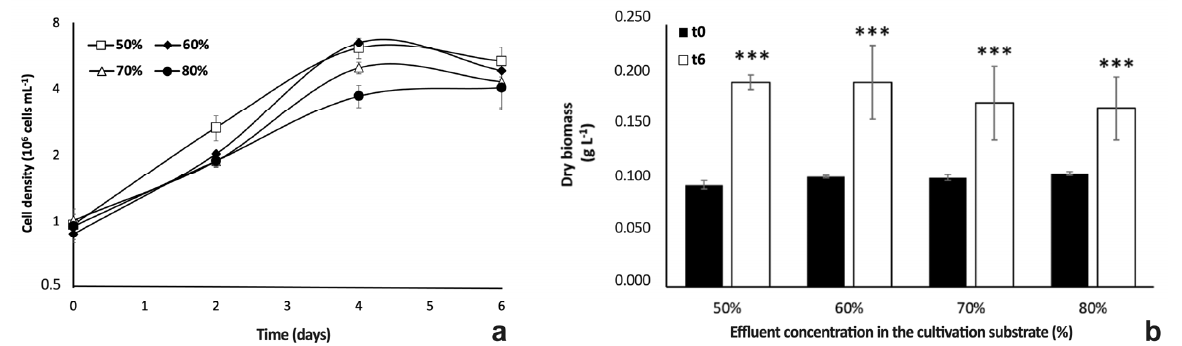
Figure 3. Growth kinetics ( a ) and dry biomass yields ( b ) of Chlorella sp. cells cultivated in centrate stream at 4 different concentrations: 80%, 70%, 60%, and 50% (percentage of effluent in freshwater). For growth kinetics, cell densities (10 6 cells mL − 1 ) are plotted on a base 2 logarithmic scale. In ( a ) timecourse variations of cell density of algae cultivated in diluted centrate at 50% (empty squares), 60% (black filled diamonds), 70% (empty triangles), and 80% (black filled circles). In ( b ) dry biomass yield (gL − 1 ) of cultures at the inoculation time (black histograms), and 6 days after inoculation time (white histograms). For each sample, values are means ± s.d. ( n = 3). In the case of cell density ( a ), the differences among cultures are significant for day 2 and day 4 after inoculation (one-way ANOVA at: t2, F(3,8) = 23.176, p < 0.001; t4, F(3,8) = 49.715, p < 0.001; t6, F (3,8) = 3.014, p = 0.0941). In the case of dry biomass yield ( b ), differences between inoculation time and day 6 are significant for all cultures (two-tails Student’s t test; *** p <